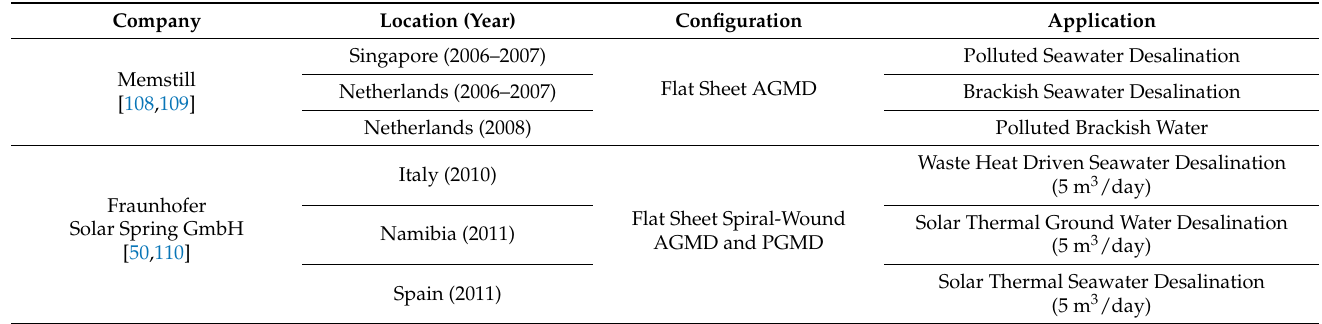
Table 2. MD pilot systems deployed in different parts of the world.